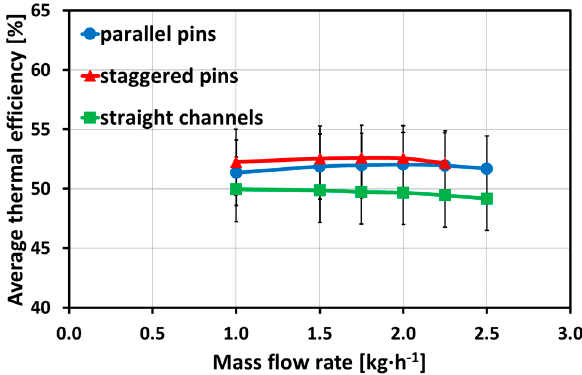
Figure 10. Average thermal efficiency as a function of mass flow rate for parallel pins, staggered pins, and straight channels; zoom in on the ordinate (40%–65%) to highlight the different behaviors (with a maximum uncertainty of ∆ ε Th = ±2.8%).